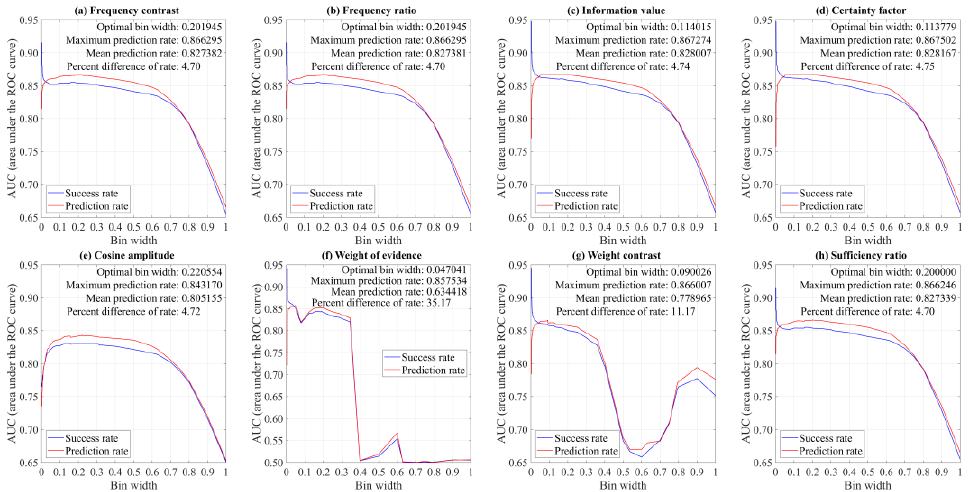
Figure 8. Variations in success rate and prediction rate with bin width during the optimization of bivariate methods in the case study. ( a ) The frequency contrast method. ( b ) The frequency ratio method. ( c ) The information value method. ( d ) The certainty factor method. ( e ) The cosine amplitude method. ( f ) The weight of evidence method. ( g ) The weight contrast method. ( h ) The sufficiency ratio method.